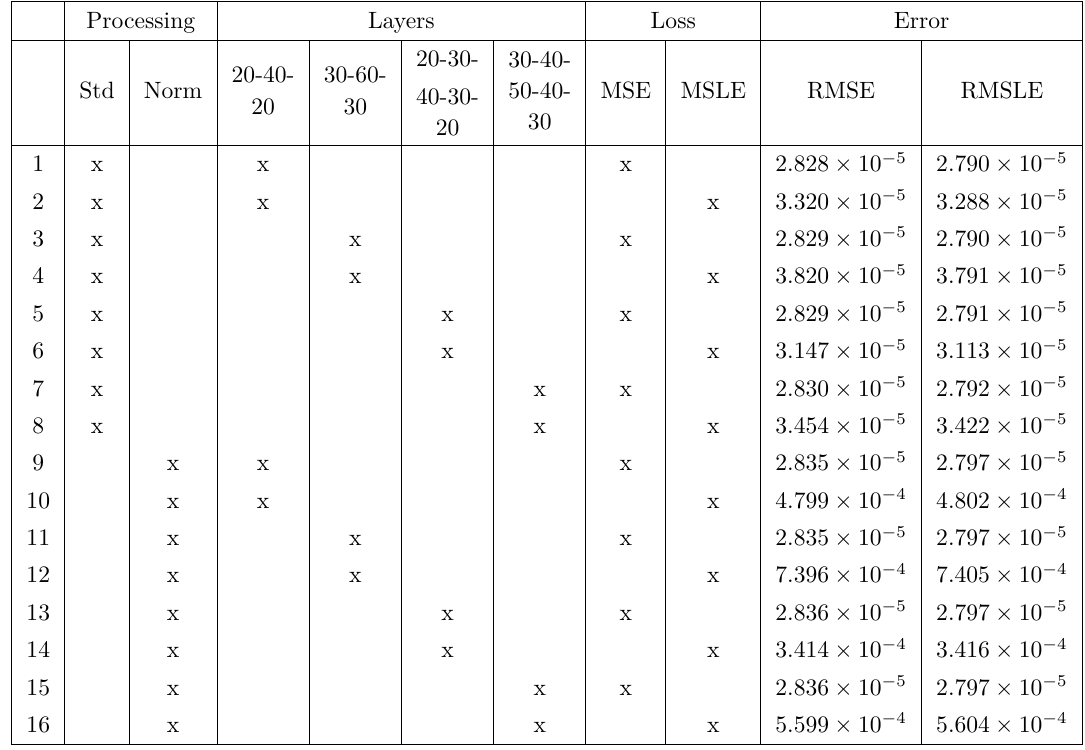
Table 2. Hyperparameter tuning results. Tuning was performed on a fixed training dataset size of 100k points sampled using the RAMBO integrator [84] on a unit integration grid. Performance was measured with respect to both the Root Mean Squared Error (RMSE) and Root Mean Squared Logarithmic Error (RMSLE) so as to avoid biasing the error measure to the optimisation criterion (loss function)